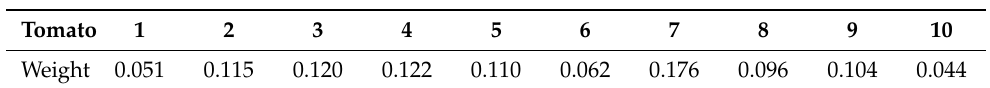
Table A32. Weight of each criterion for